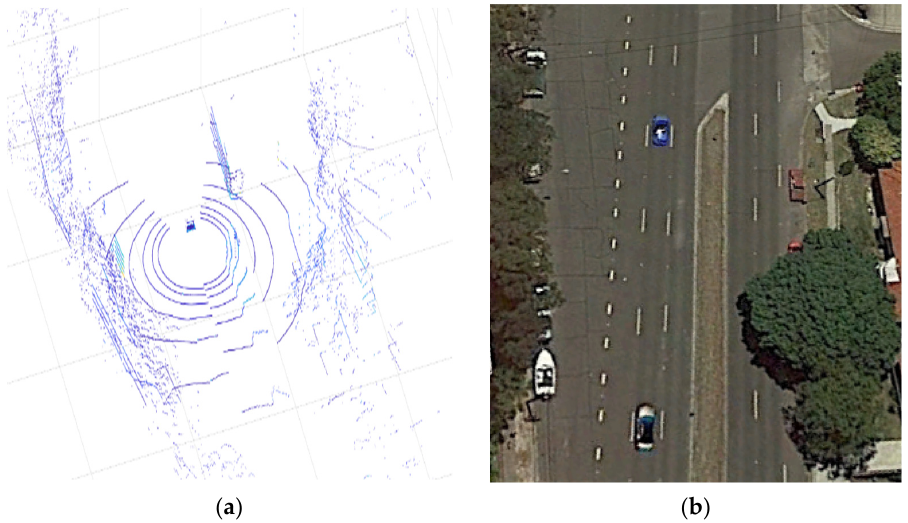
Figure 20. Scan frame at epoch 41,103 s with big outlier in Trajectory Section 3, with one tall bus driving past ( a ) Lidar scan; ( b ) Google Earth view.